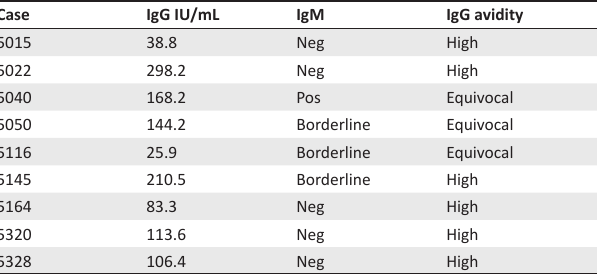
TABLE 3: Anti- Toxoplasma gondii IgG and IgM seropositivity and IgG avidity among pregnant women.